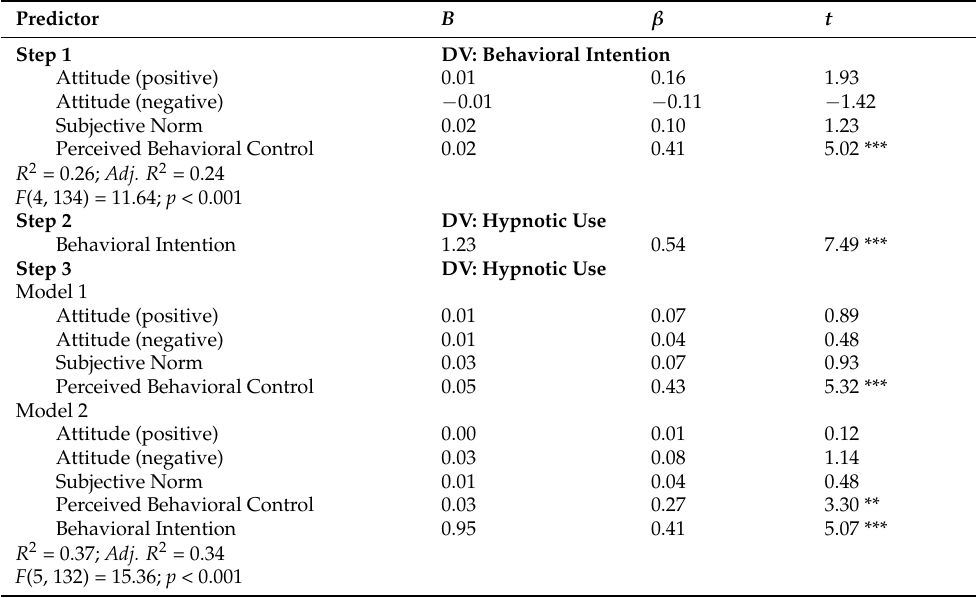
Table 2. Hierarchical regression coefficients for the test of the Theory of Planned Behavior to predict medication use at the 3-month